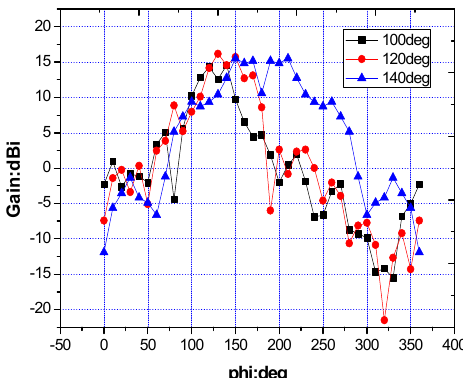
Figure 5. Radiation patterns with different angle α measurements at 59 GHz.